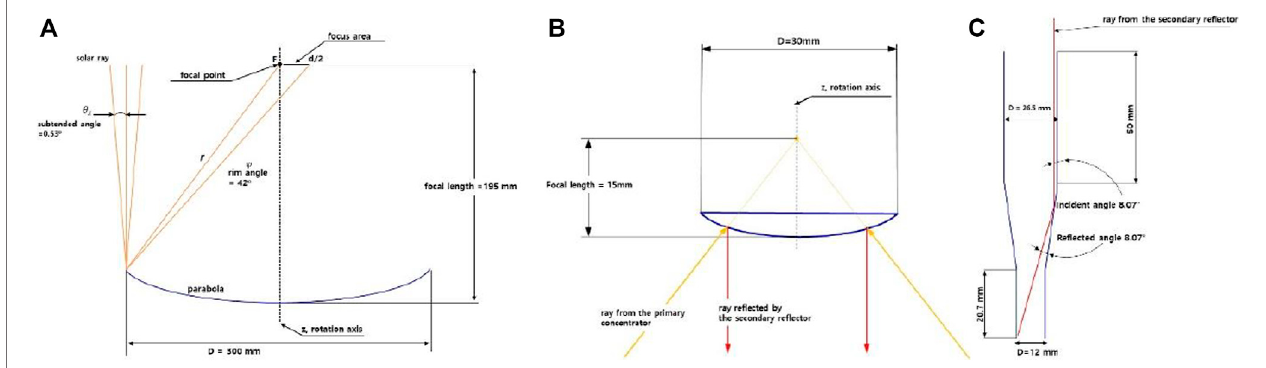
FIGURE 1 | Drawings of each component of the concentrator module-1: (A) the primary parabolic concentrator, (B) the secondary re fl ector, and (C) the homogenizer.